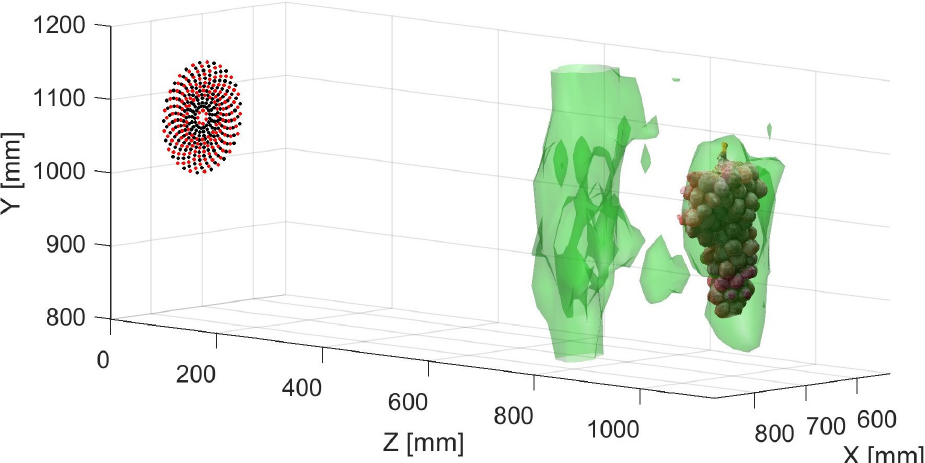
Figure 12. An plot showing an RMS isosurface plot for scans of a grape bunch (at about z = 1100 mm) and leaves (at about z = 700 mm), where 20 averages were made of the measurement at each position. The 3D photogrammetry scan of the grapes and the microphone (black dots) and transducer (red dots) arrays have been overlaid. It can be seen that the volume of the leaves is significant.